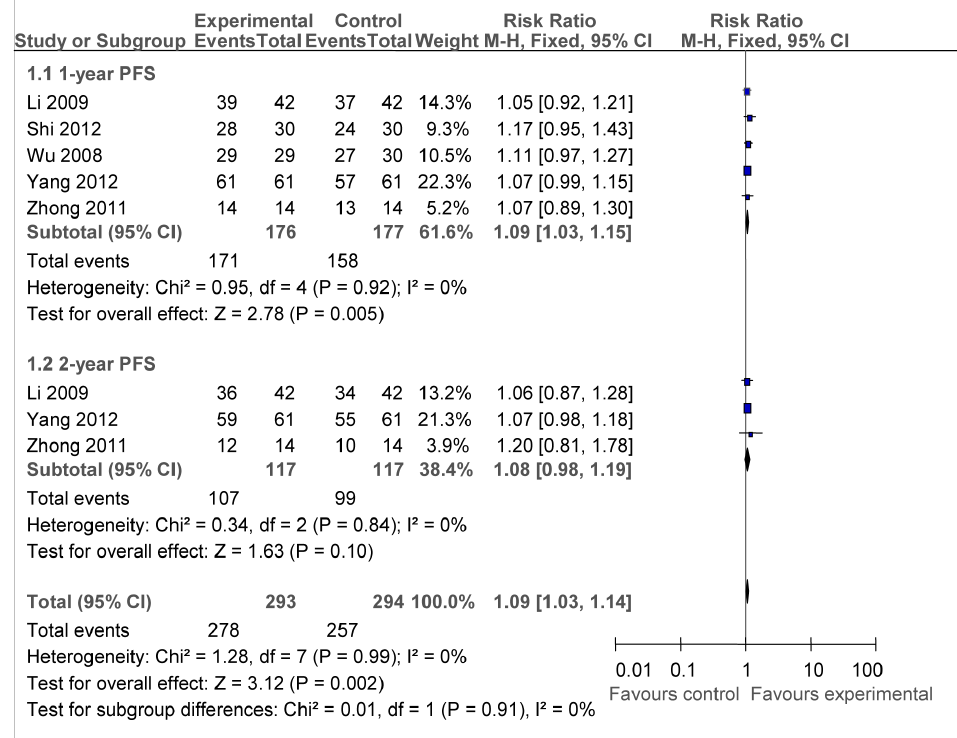
Figure 3. Forest plot of the comparison of progression free survival (PFS). P values are from P for the effect modification evaluation of heterogeneity within or across the groups of regimens. CI, confidence interval; RR, risk ratio; DC/CIK, DC-CIK immunotherapy; Chemo, chemotherapy; Con, control group; Exp, experimental group. A fixed-effect meta-analysis model (Mantel-Haenszel method) was used.